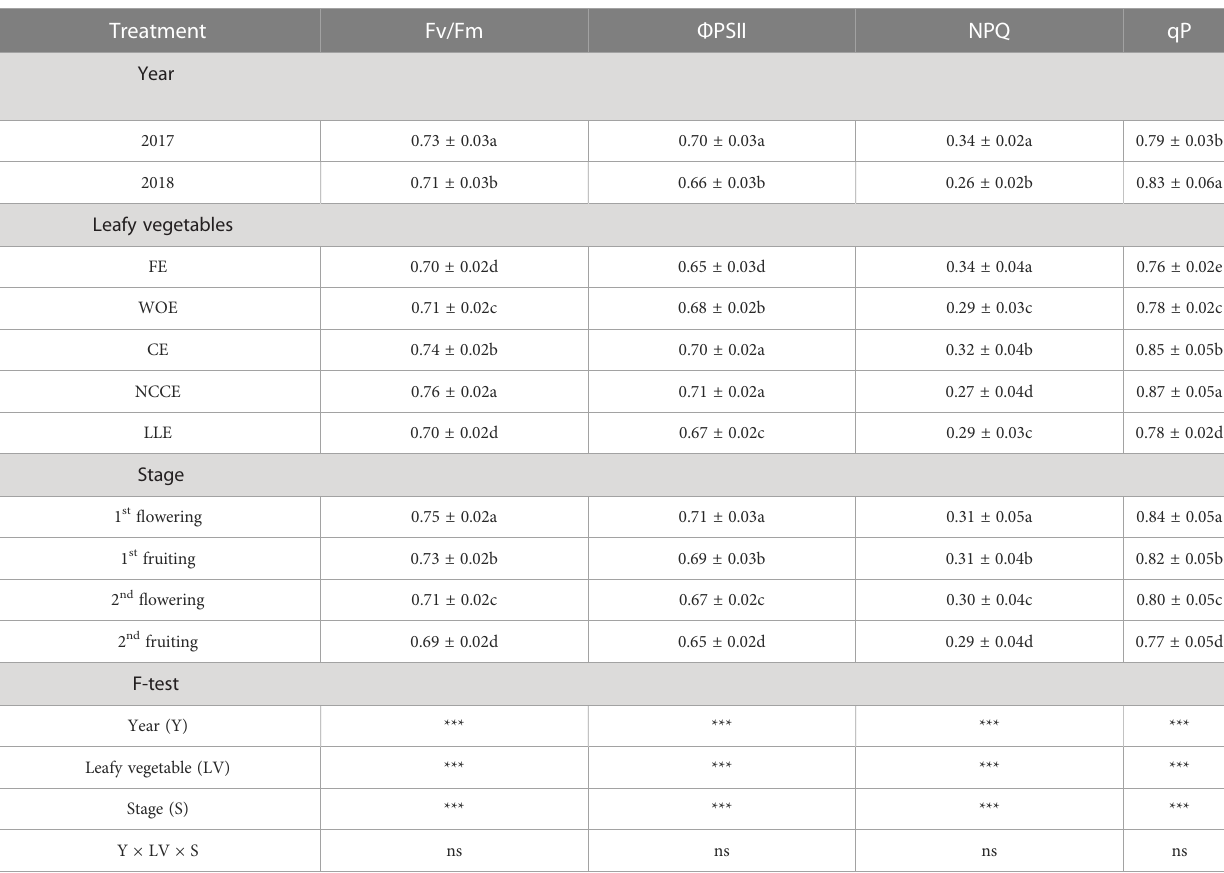
TABLE 3 Effect of different leafy vegetable rotation systems on chlorophyll fl uorescence parameters of eggplant at different growth stages during the year 2017 and